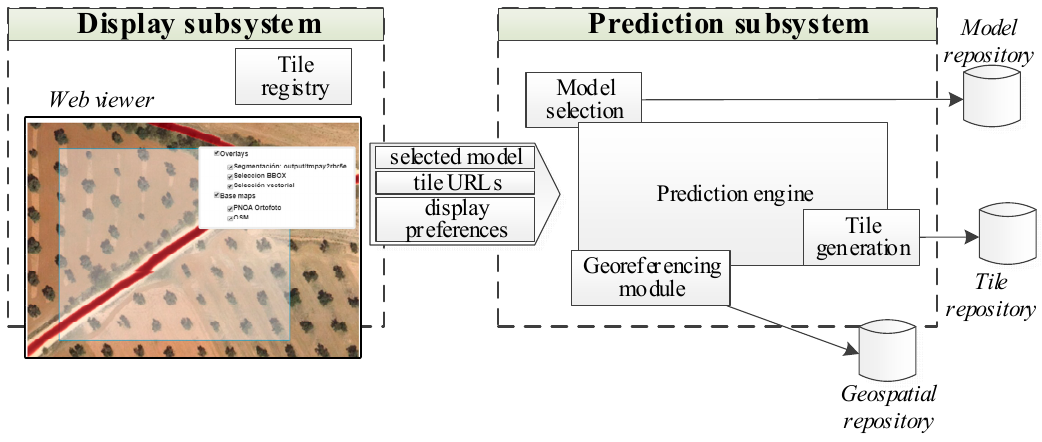
Figure 8. Architecture of the web platform.